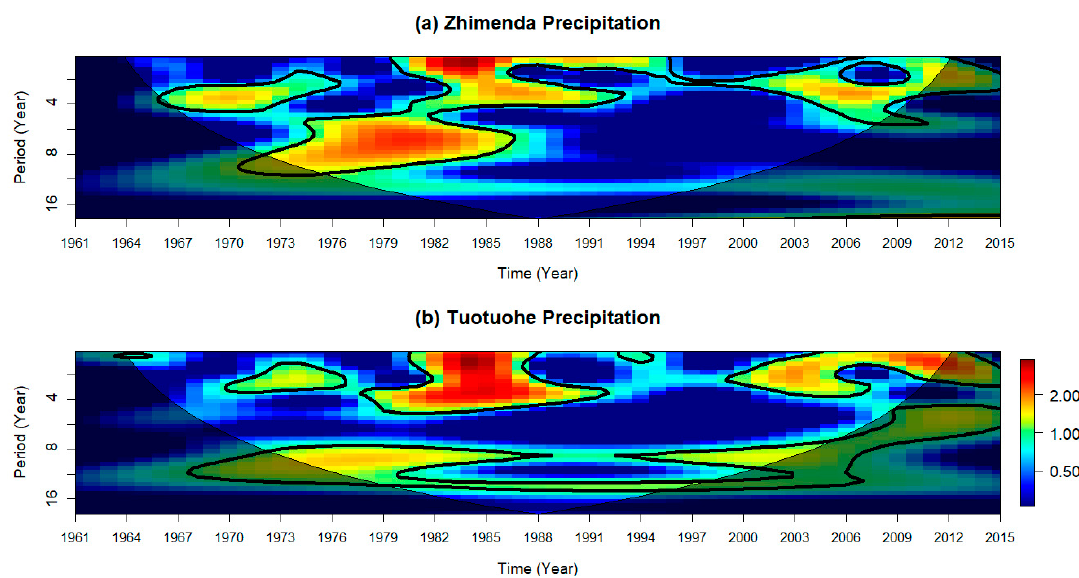
Figure 7. Wavelet power spectrum for the annual areal averaged precipitation for Zhimenda and Tuotuohe sub-basins during 1961–2015. The black line shows statistical significance at the 0.05 level.